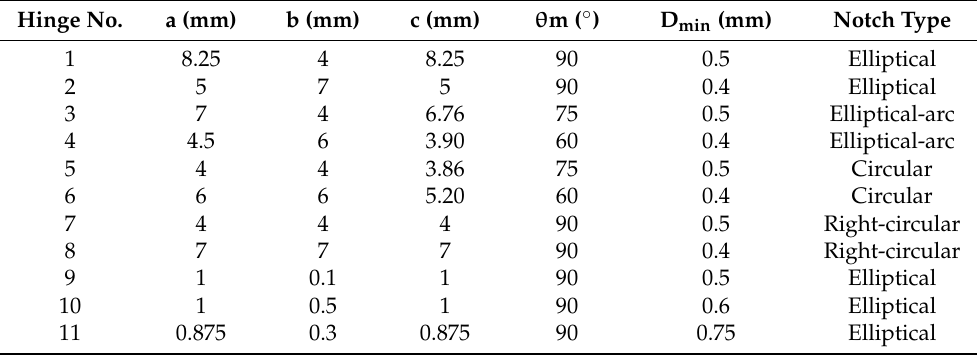
Table 1. Geometric parameters of the elliptical-arc spherical flexure hinges. Hinge